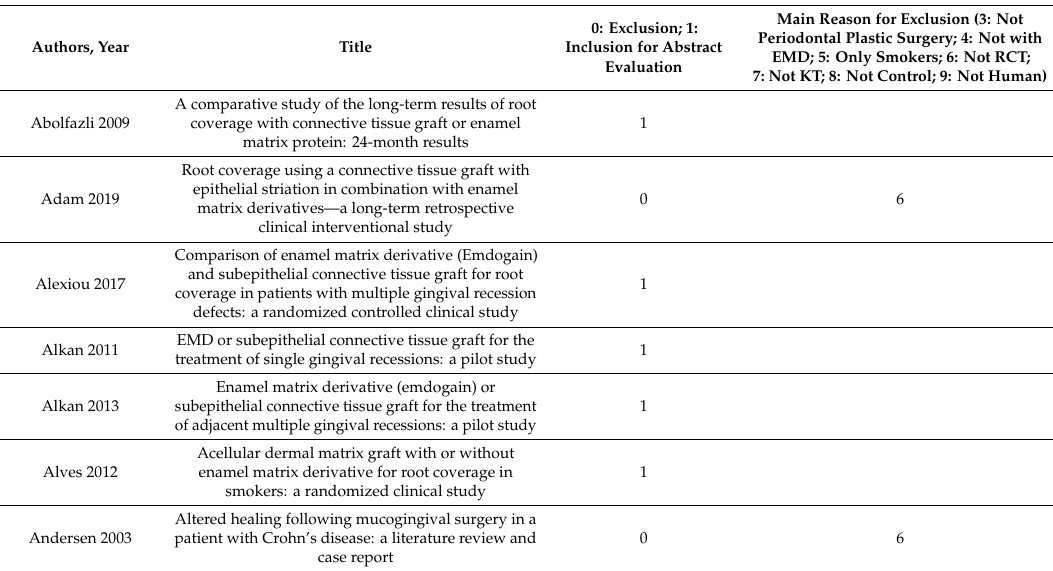
Table A2. Abstract and Title